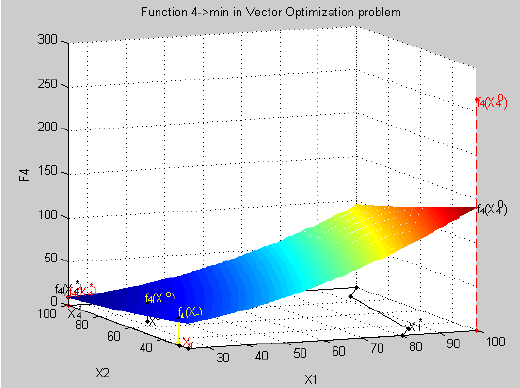
Figure 12. The fourth characteristic f 4 ( X ) of the technical system in a natural indicator.